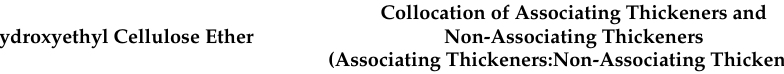
Table 5. Compositions of the paints for Design 3